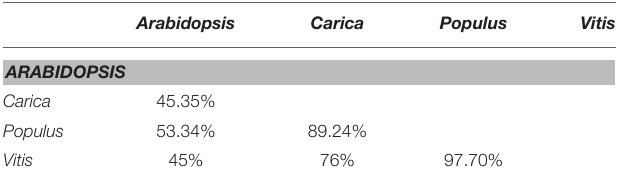
TABLE 3 | The synteny quality of regions orthologous across four modern